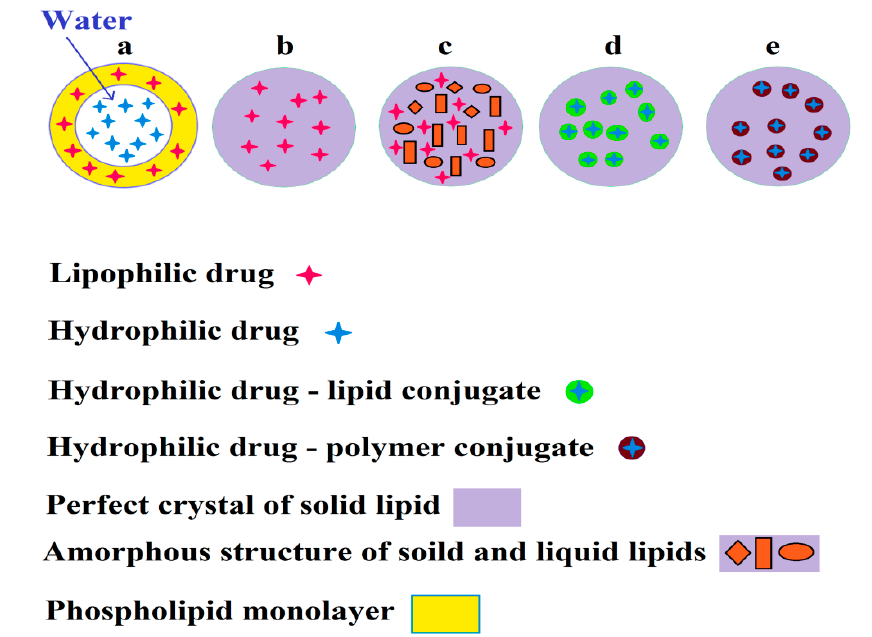
Figure 4. Encapsulation of lipophilic and hydrophilic drugs by a liposome (a), solid lipid nanoparticles (b), nanostructure lipid carriers (c), lipid–drug conjugates (d), and polymer–drug conjugates